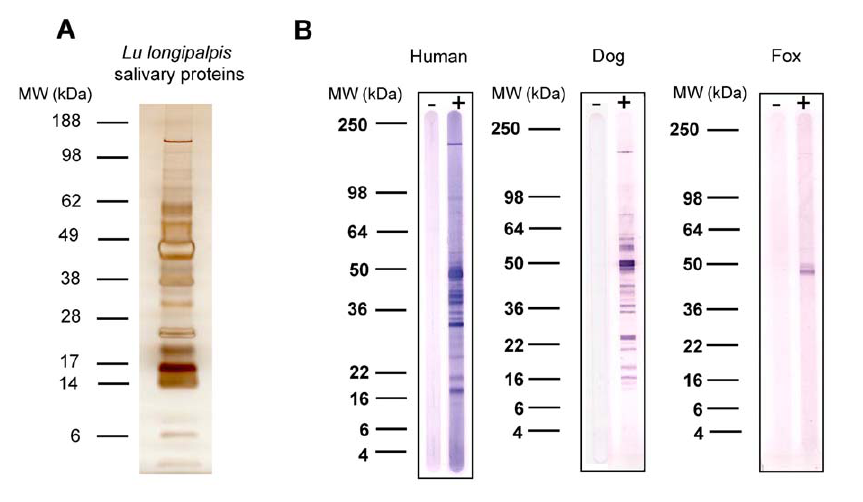
Figure 1. Lutzomyialongipalpis salivary proteins recognized by human, dog and fox sera from the visceral leishmaniasis endemic areas of Sa˜o Luis and Teresina. A , Silver staining of a Bis-Tris NuPAGE gel of salivary proteins from Lu. longipalpis . B , Western Blot of salivary proteins of Lu. longipalpis separated on a Tris-Glycine gel using a representative reactive sera from either human (Sa˜o Luis), dog or fox (Teresina).